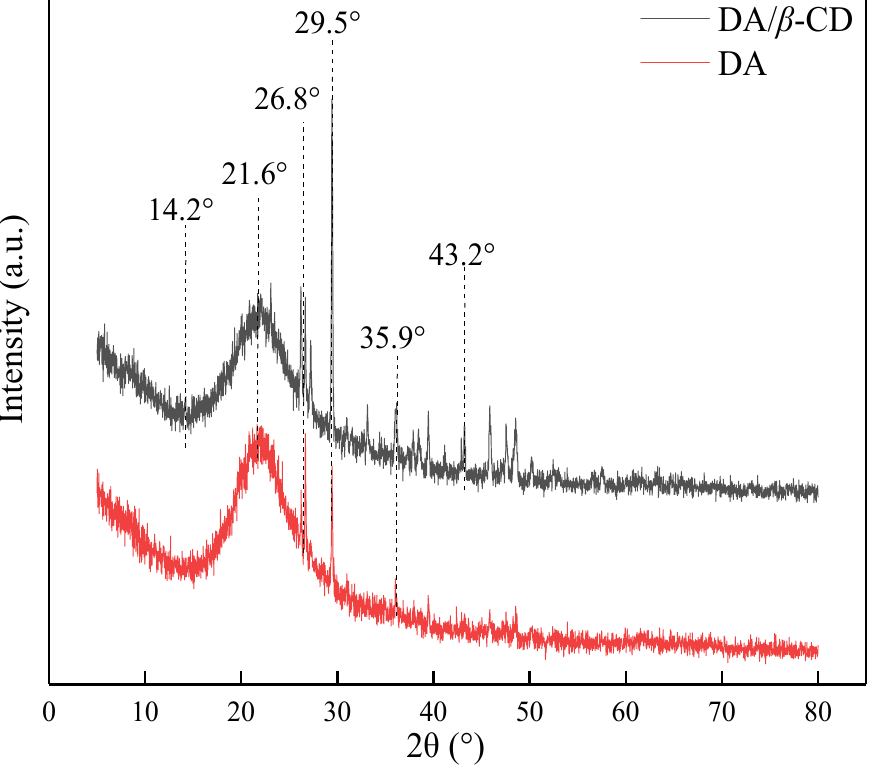
Figure 4. XRD pattern of DA and DA/ β -CD.